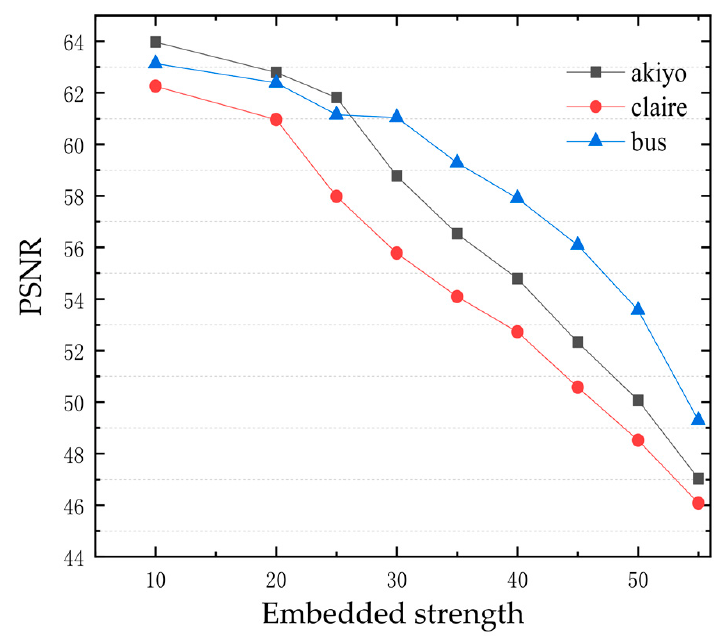
Figure 6. Relationship between PSNR and embedded strength.